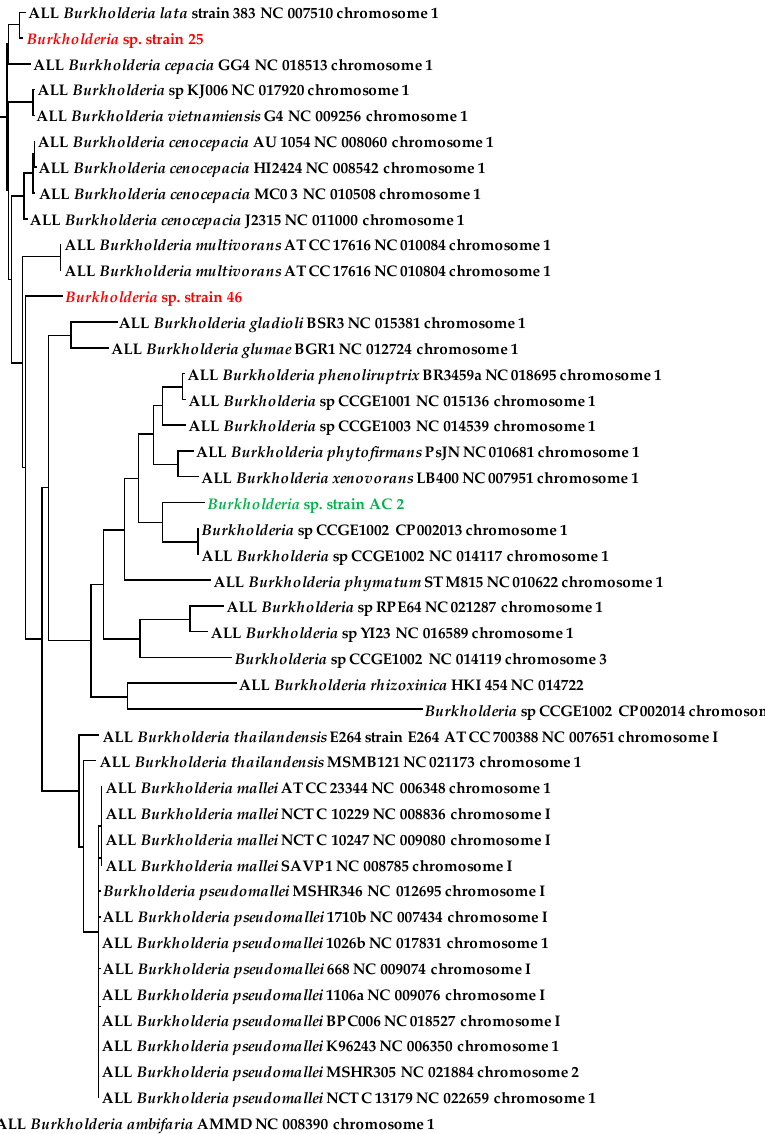
Figure 3. Depicted is the genome-wide phylogenetic tree of Burkholderia species reported in this study. Tree for 45 genomes was built using the EDGAR pipeline, out of a core of 2 genes per genome, 90 in total. The core consists of 1155 AA-residues/ bp per genome, 51,975 in total. Shown in red color are the two Burkholderia species isolated from SRS soils reported in this study, and the one shown in green color was obtained from a previous study.